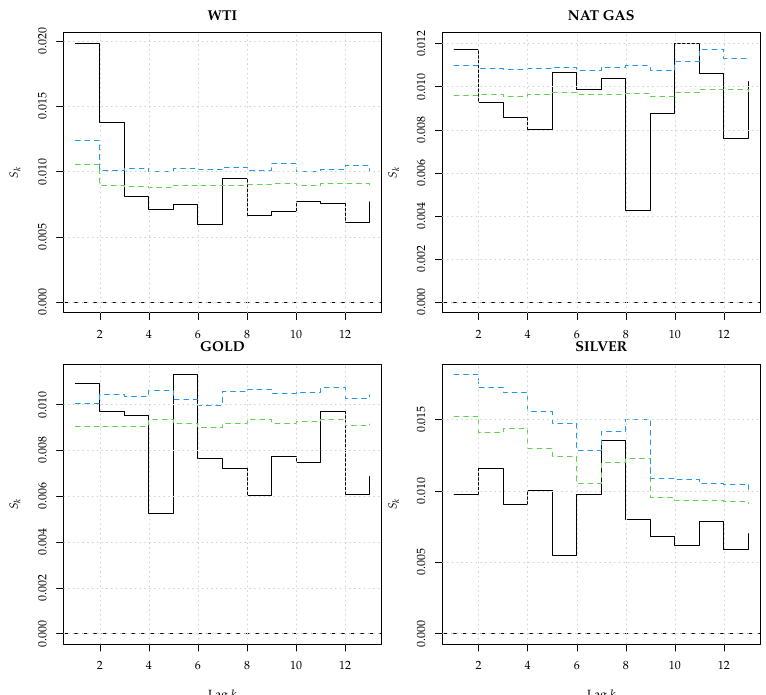
Figure 20. Serial entropy S k for lag k = 1, . . . ,13 (black, solid line), computed on the residuals of a ARMA ( 1,1 ) –GARCH ( 1,1 ) model fitted upon the series of commodity prices. The rejection bands at 95% (green dashed line) and 99% (blue dashed line) correspond to the null hypothesis of a general linear